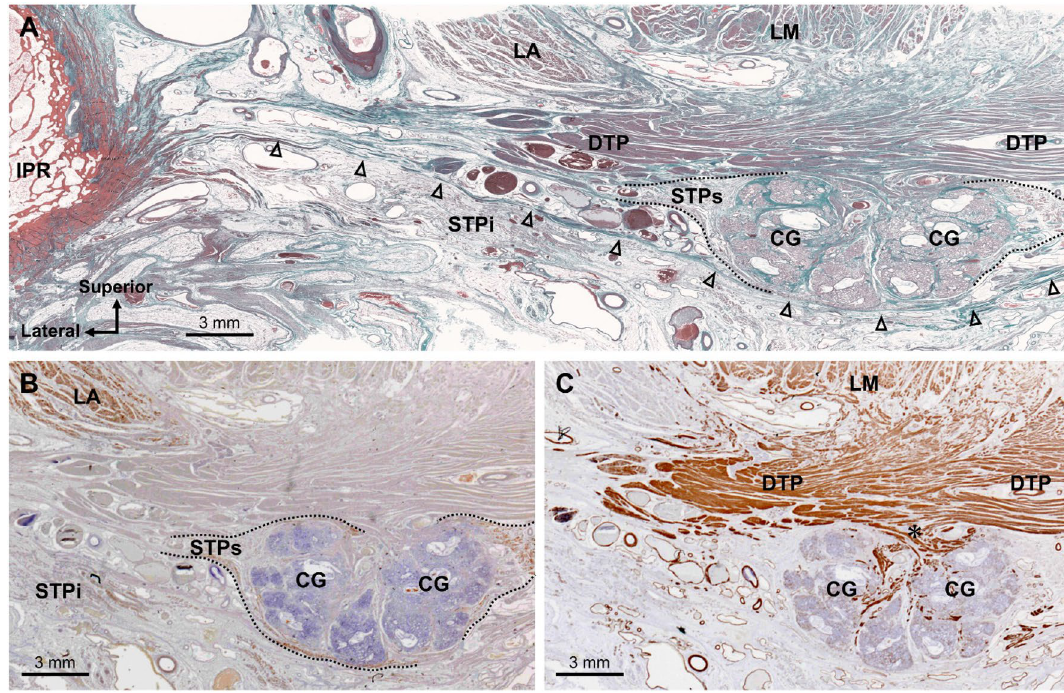
Figure 5. Coronal sections of the Cowper’s gland and surrounding muscles. ( A ) A coronal section with Elastica Masson’s staining. The CG was observed superior to the perineal membrane (arrowheads). The STPi was observed inferior to the perineal membrane, and the STPs and DTP were observed superior to the perineal membrane in the deep perineal pouch. ( B ) Immunostaining for striated muscle. The striated muscle fibers of the STPs covered the lateral side of the CG. ( C ) Immunostaining for smooth muscle. The DTP covered the superior side of the CG and consisted of smooth muscle fibers. Its smooth muscle fibers partially extended between the bilateral CGs and between their lobules (asterisk). CG Cowper’s gland, DTP deep transverse perineal muscle, IPR ischiopubic ramus, LA levator ani, LM longitudinal muscle, STP superficial transverse perineal muscle,